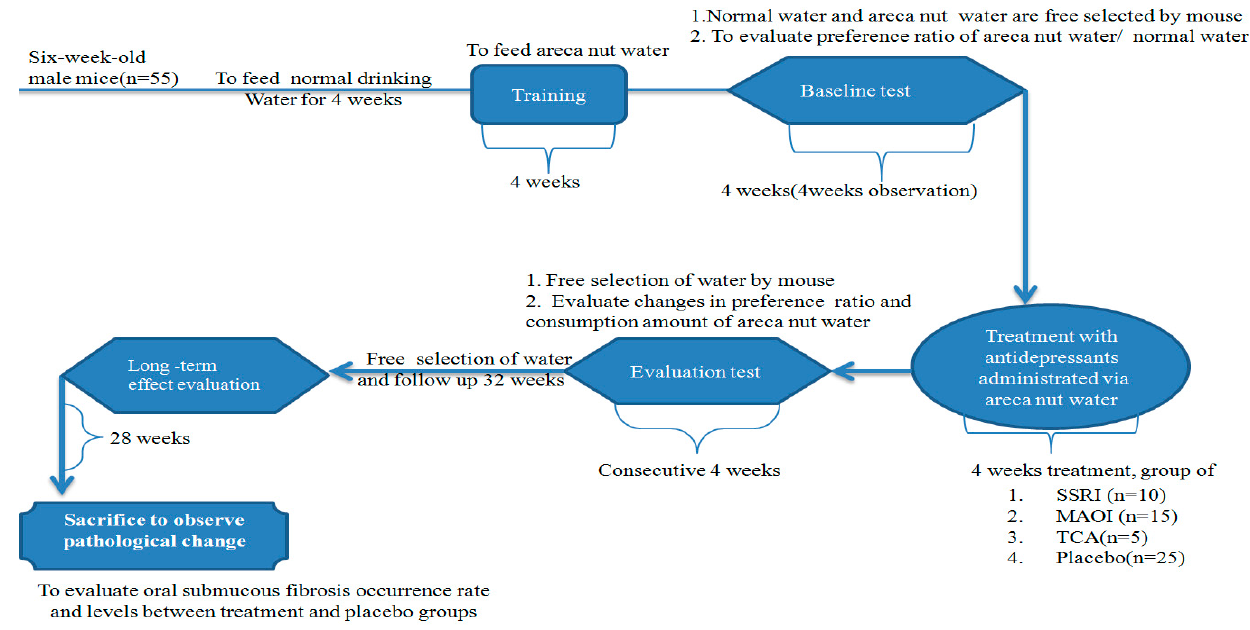
Figure 1. Schematic of evaluation of areca-nut use with antidepressant treatment in animal model.